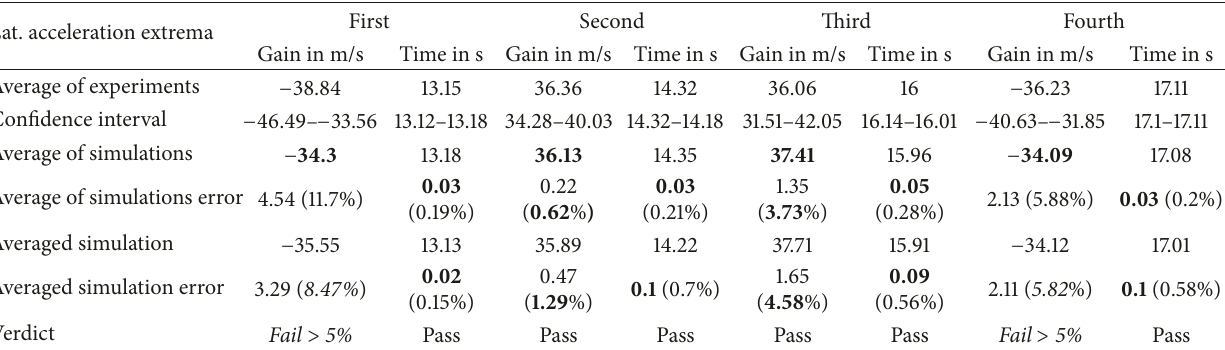
Table 7: Validation results Maneuver Lat-II: lateral acceleration extrema.